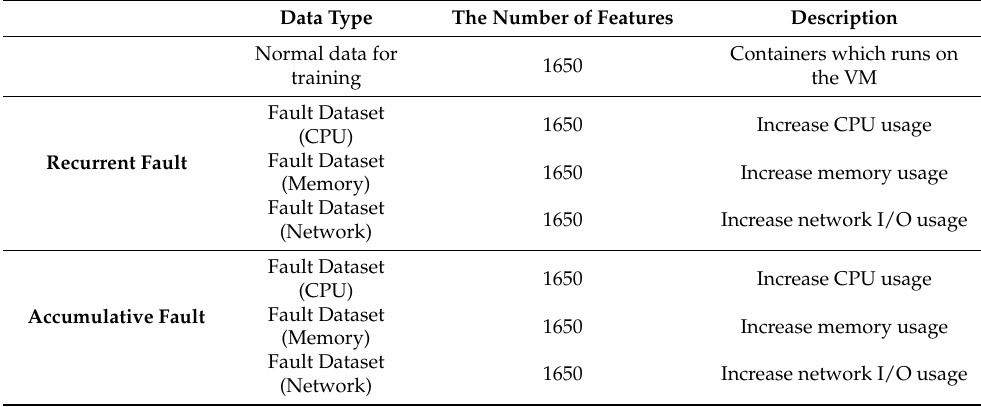
Table 1. Dataset for Fault